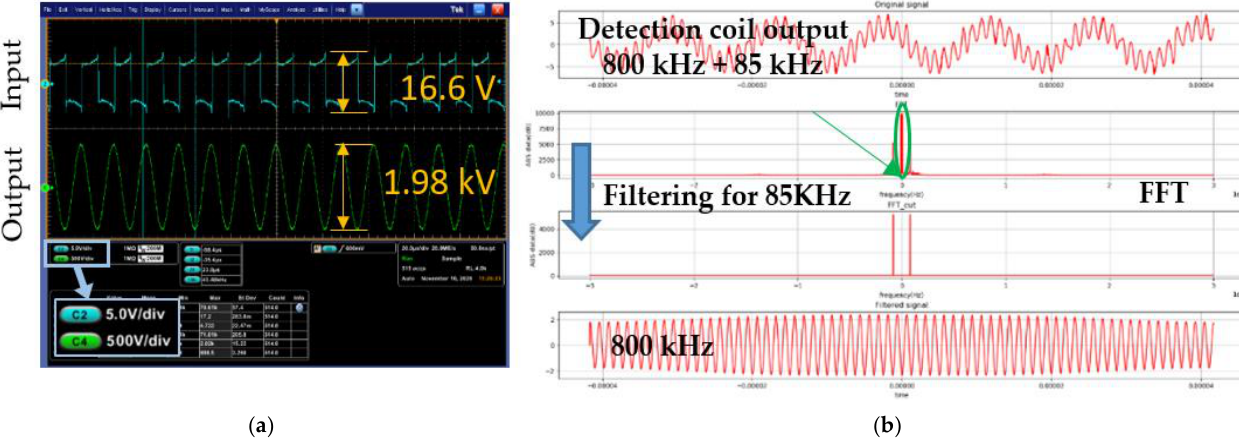
Figure 11. Removal of interference signal from the detection coil by the WPT system. ( a ) Input voltage of the inverting circuits and output voltage of the power transmitting coil and ( b ) output voltage of the detection coil before and after signal removal of the WPT system.